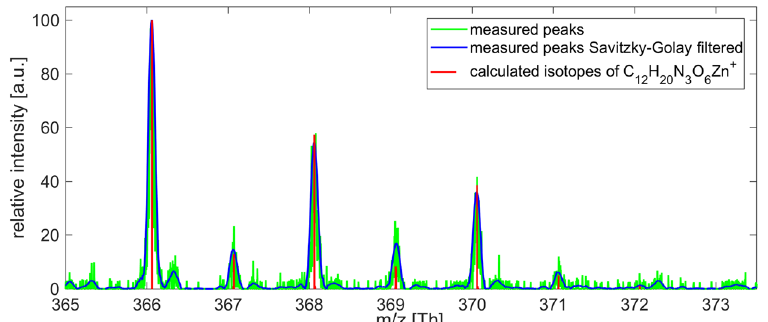
Figure 6. Measured isotopic pattern of the m/z 366 peak recorded as fragment ions at a mobility diameter of 1.62 nm. Also shown is the calculated isotope pattern of C 12 H 20 N 3 O 6 Zn + , which gives an excellent